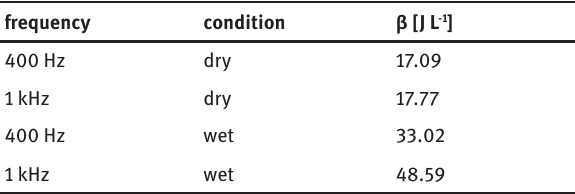
Figure 4: Molar fraction of toluene under dry (black boxes) and wet (red circles) conditions at 400 Hz (left) and 1 kHz (right). Table 1: Energy density parameters for the different settings